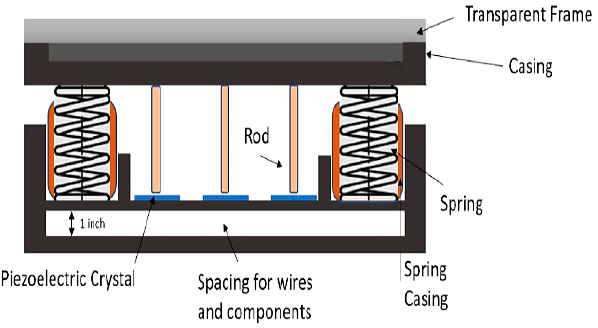
Figure 1. Example of piezoelectric tile.